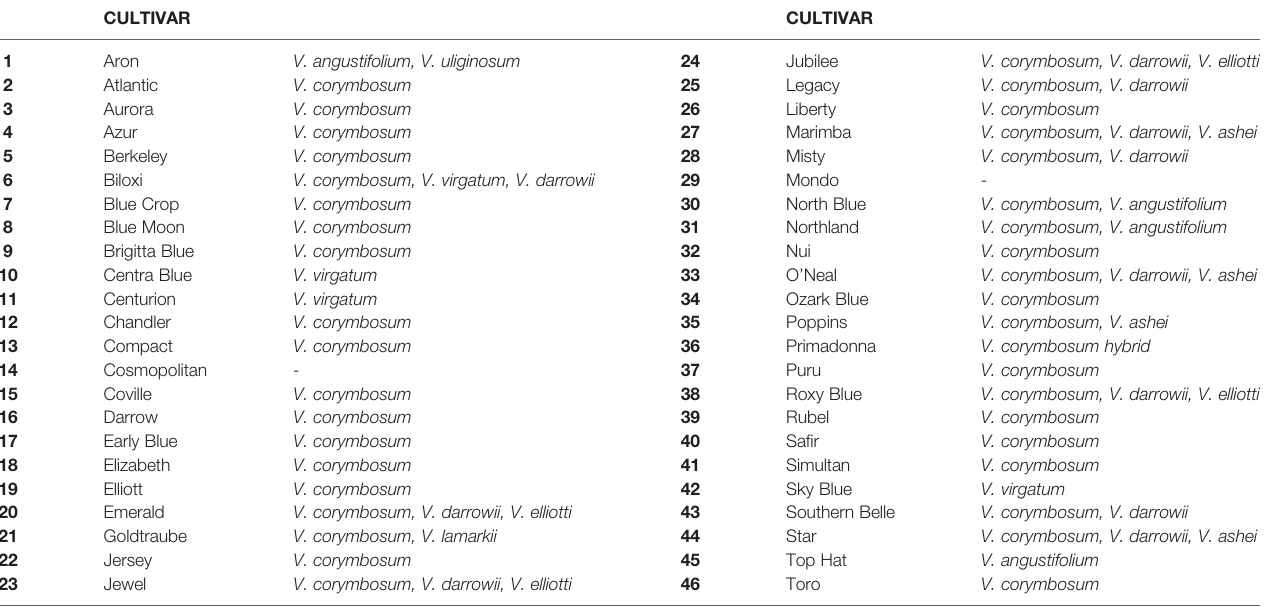
TABLE 1 | List of the Vaccinium spp. cultivars employed in this